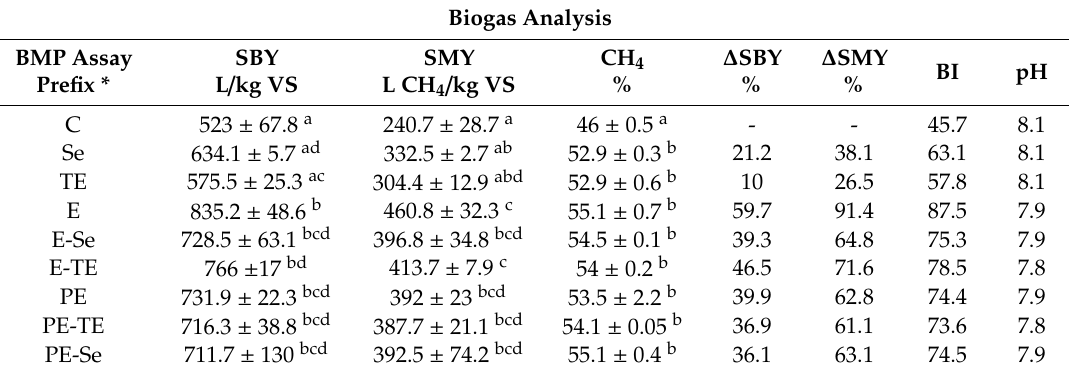
Table 4. Biogas analysis, biodegradability index (BI) and pH of BMP